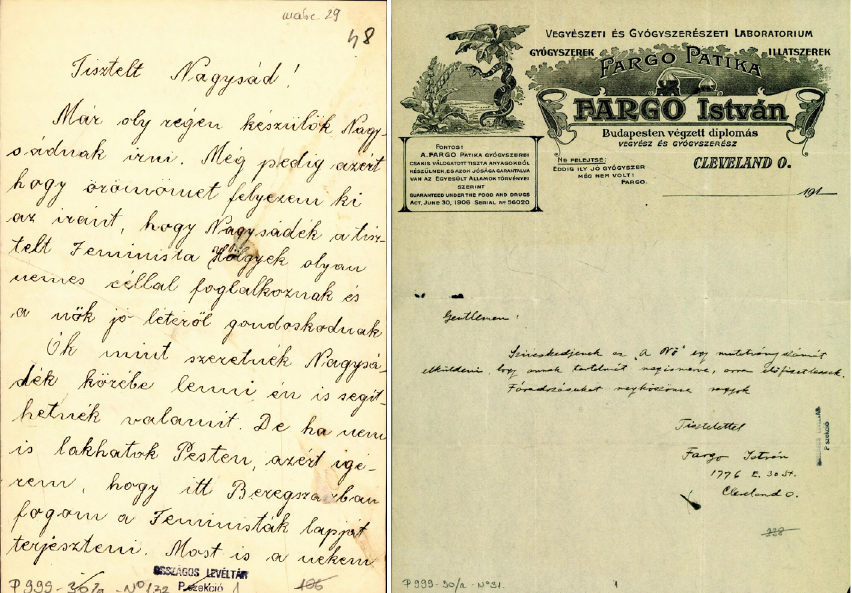
Fig. 4a/b Letters to the editors of A Nő from Beregszász (now Beregovo, Ukraine)